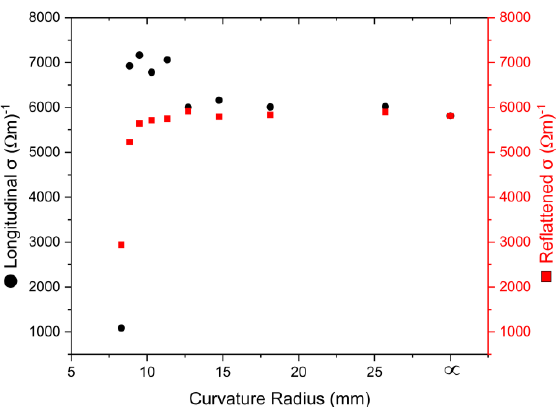
Figure 3. Behaviour of longitudinal and reflattened conductivity versus radius for positive bending at room temperature (20 °C). The former showed an enhancement about 23% at 9.5 mm before an abrupt fall beyond this critical radius of curvature. The latter does not recover its initial values for radius smaller than 9.5